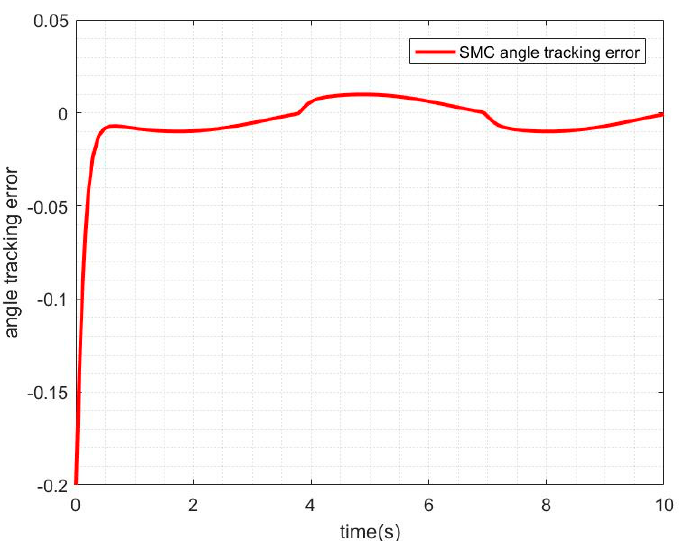
Figure 7. SMC angle tracking error with friction disturbance.